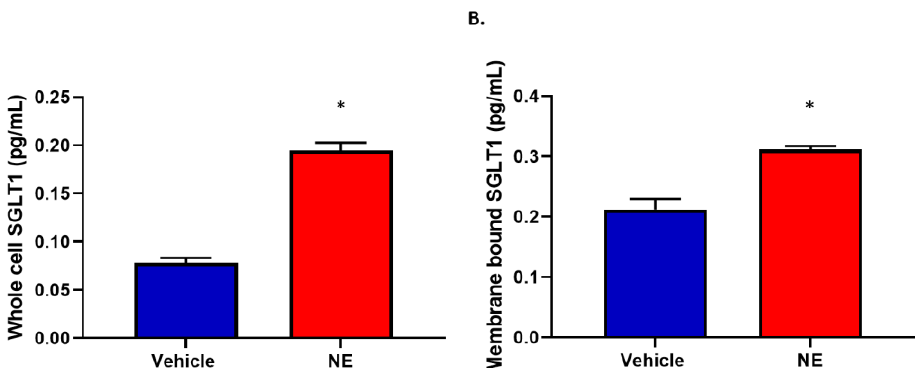
Figure 4. SGLT1 protein levels are elevated and translocate to the cell membrane following NE (10 µ M) treatment of HK2 cells. ( A ) whole cell lysates; data represented as mean ± SEM; n = 5/group; * p = 0.0000019 ( B ) membrane bound SGLT1; data represented as mean ± SEM; n = 3/group; * p = 0.006; SGLT1, Sodium glucose cotransporter 1; NE, Norepinephrine.